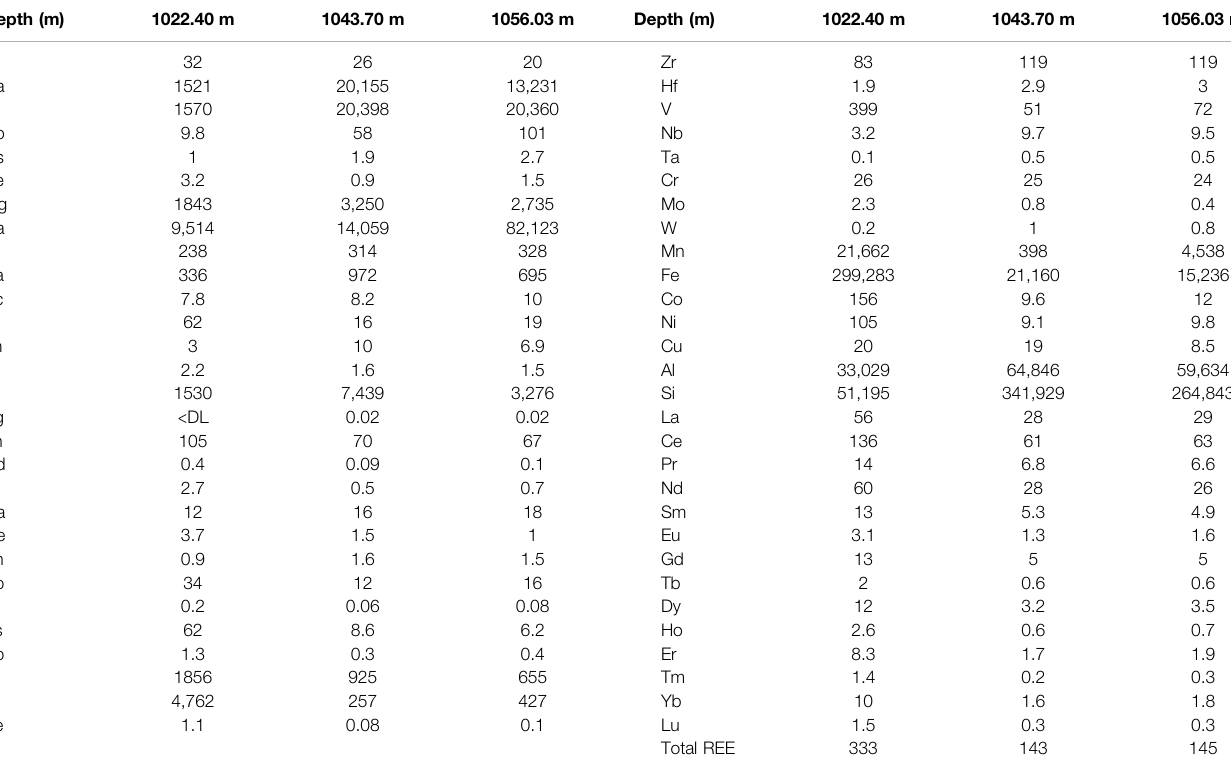
TABLE 3 | Rock total element digest data (mg/kg) for the three cores. Data for a wider range of Evergreen Formation samples from the West Wandoan 1 well core are inthe SupplementaryMaterial .Rocktotaltraceelementandrareearthelement(REE)digestdata(mg/kg)forthethreeWestWandoan1EvergreenFormationcoresarealso